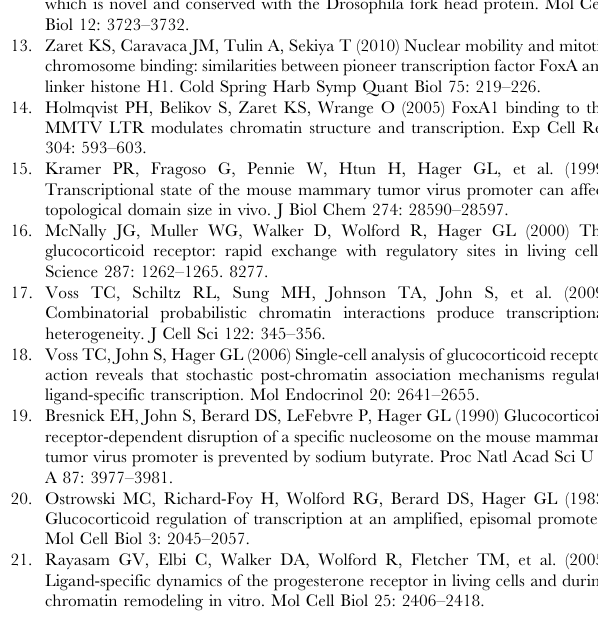
in the FISH size using the % CV. Each % CV is calculated from the same source data used for determination of the % CV for FISH intensity in Figure 5E. NS, indicates not statistically significant from the Foxa1 negative (-) sub-group as determined by the Mann-Whitney U Test. (TIF) Figure S2 Foxa1 decreases variability in the FISH intensity but not the FISH size as determined by a different noise metric termed the Fano factor. (A, B) Computations of the individual cell-to-cell variability in the FISH signal intensity and size by Fano factor calculation (variance/ mean). The Fano factor is calculated from the identical data used for determination of the % CV for the FISH intensity (Figure 5E) and size (Figure S1). Error bars represent + SEM; *, indicates a significant difference from the Foxa1 negative (-) sub-group as determined by the Mann-Whitney U Test (p , 0.05). NS, indicates not significant from the Foxa1 negative (-) sub-group.